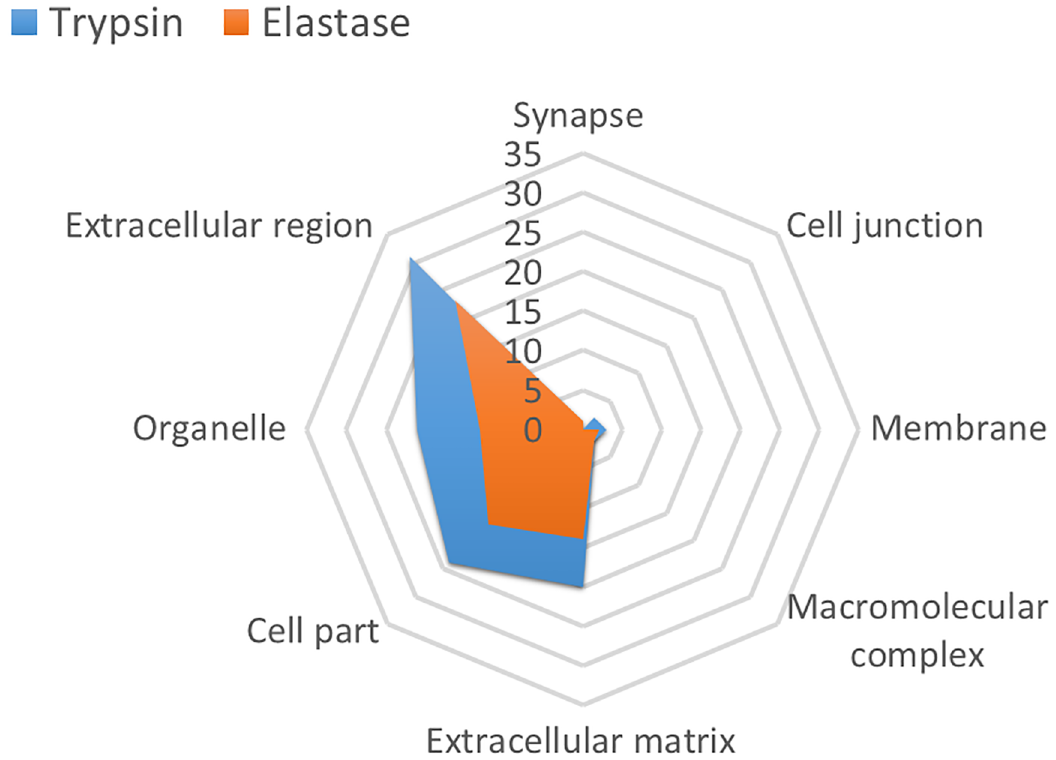
Fig 4. The number of hits in each cellular compartment in samples digested by either trypsin (blue) or elastase (orange). Identified proteins (Progenesis, 2 or more peptides)were categorized using PANTHER classification system. Although tryspin digestionyieldedmore hits, there was a similar distributionof proteinsin the